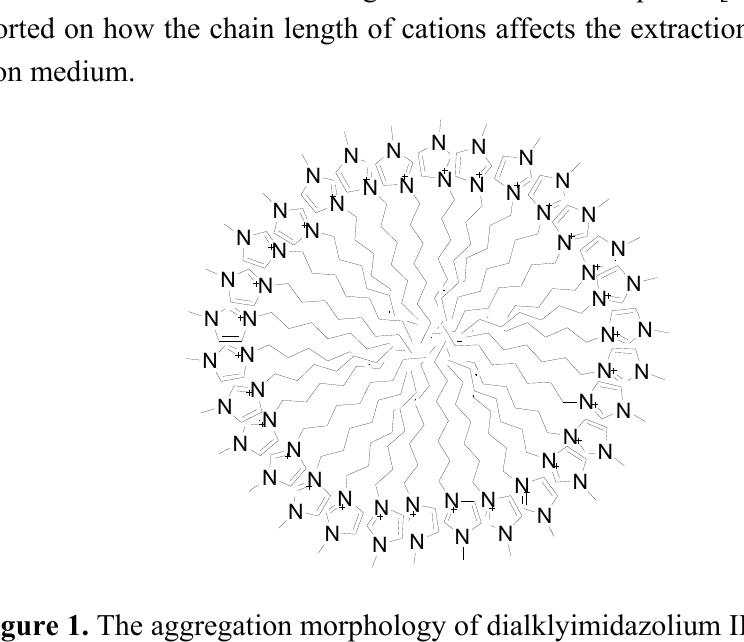
Figure 1. The aggregation morphology of dialklyimidazolium ILs in